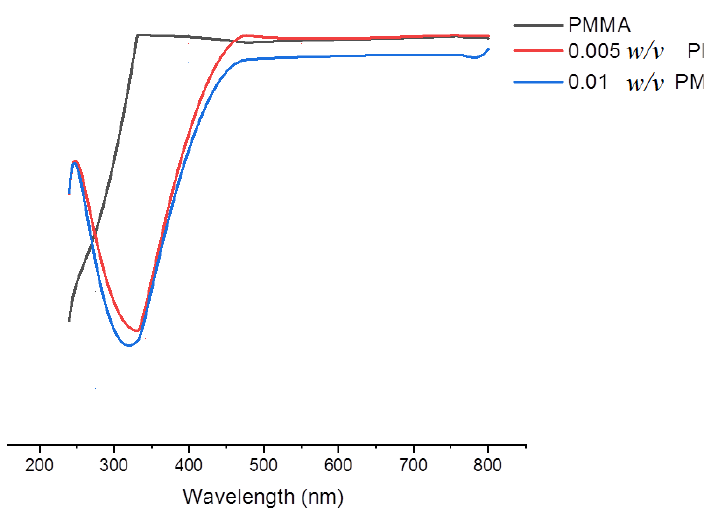
Figure 3. UV-vis transmission spectrum of pure PMMA and 0.005 and 0.01 PMMA-TiO 2 .